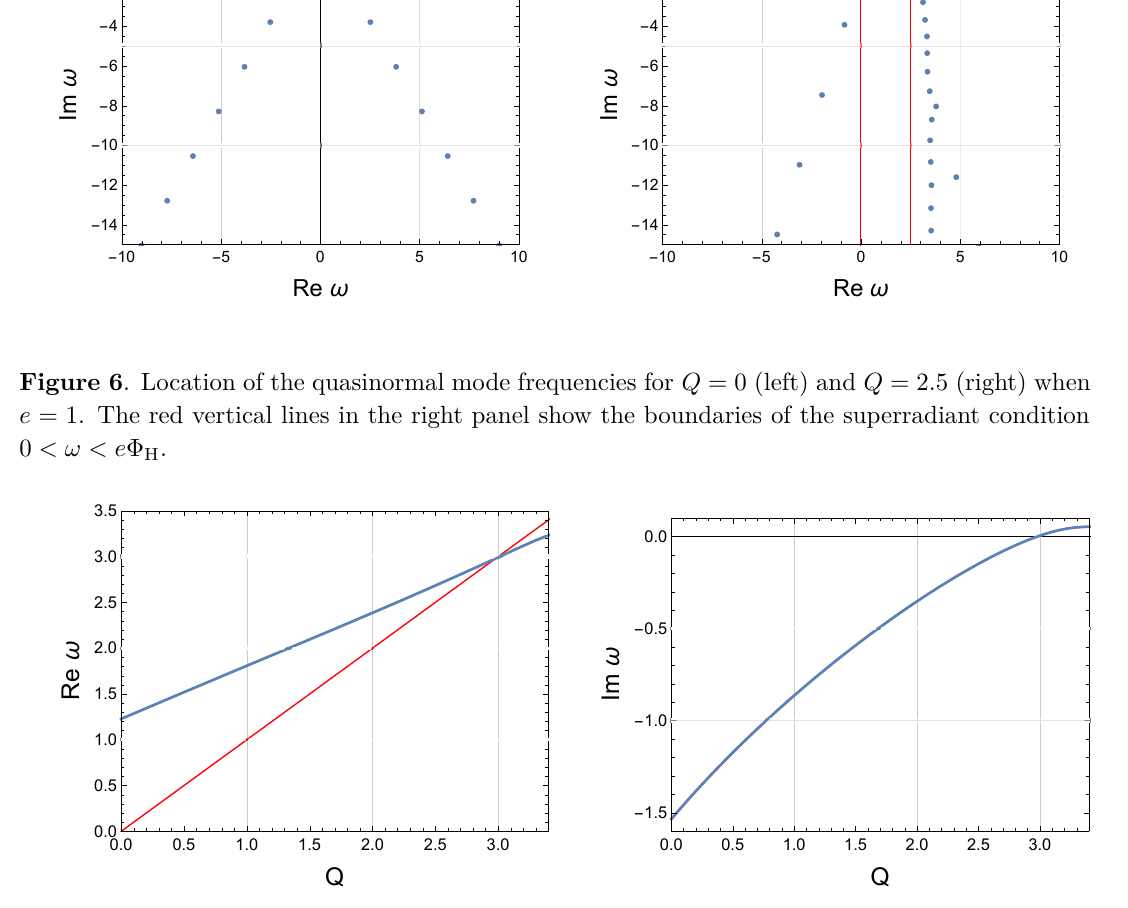
Figure 7 . The Q dependence of the real and imaginary parts of the mode with the largest Im ω . The red line in the left panes shows the upper boundary of the superradiant condition ω = e Φ H . In the right panel, the line crosses Im ω = 0 at Q = 2 . 981